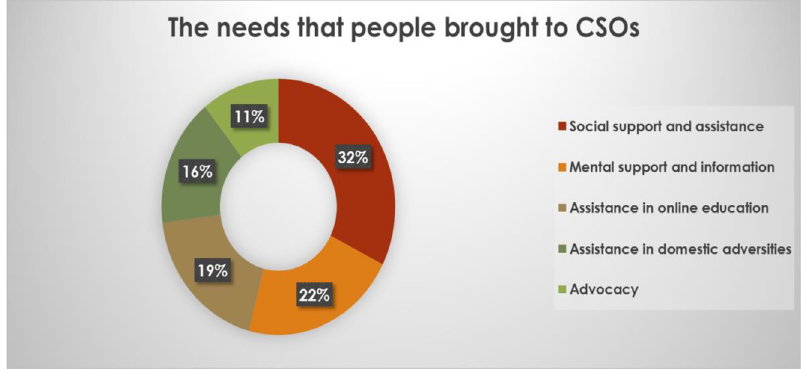
Figure9: Distributionoftheproblemsofthosewhoturntotheorganizationsparticipatinginthe study for